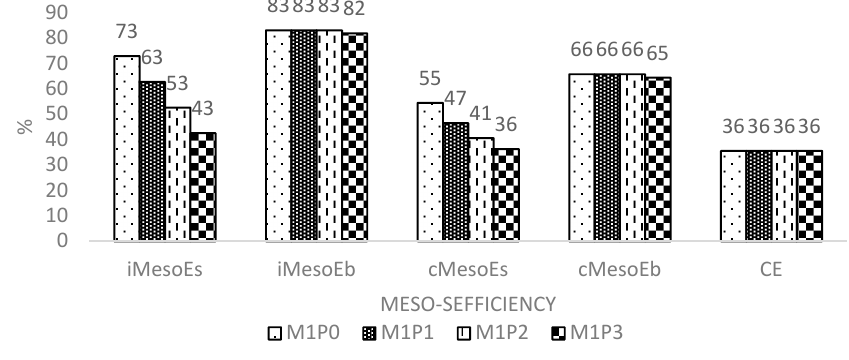
Figure 6. Sefficiency for M1P.